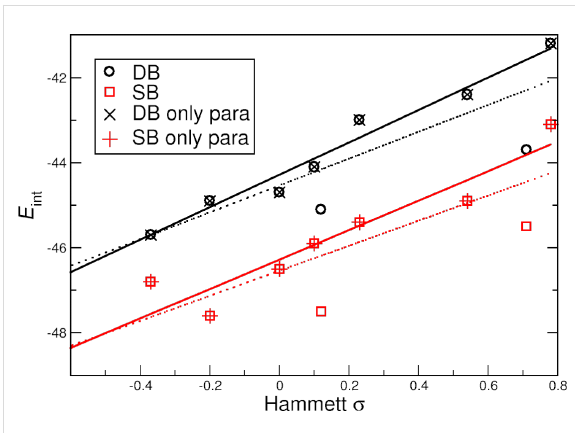
Figure 4: Interaction energies plotted against the Hammett σ parame- ters. The values are given in Table 1. Black curves: DB and red curves: SB . The solid lines are fits to all energies of the para-substitu- tion only, the dotted lines are linear regressions to all interaction ener- gies.